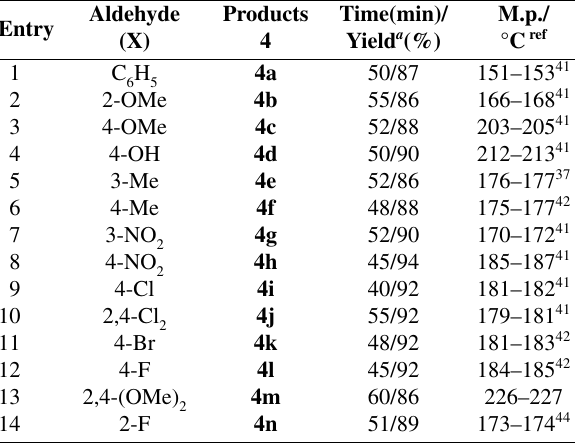
Table 3. Synthesis of tetrahydrobenzo [ a ] xanthen-11-ones cataly- zed by